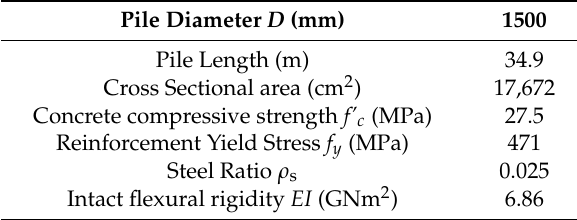
Table 2. Structural properties of bored pile, Huang et al. [43].